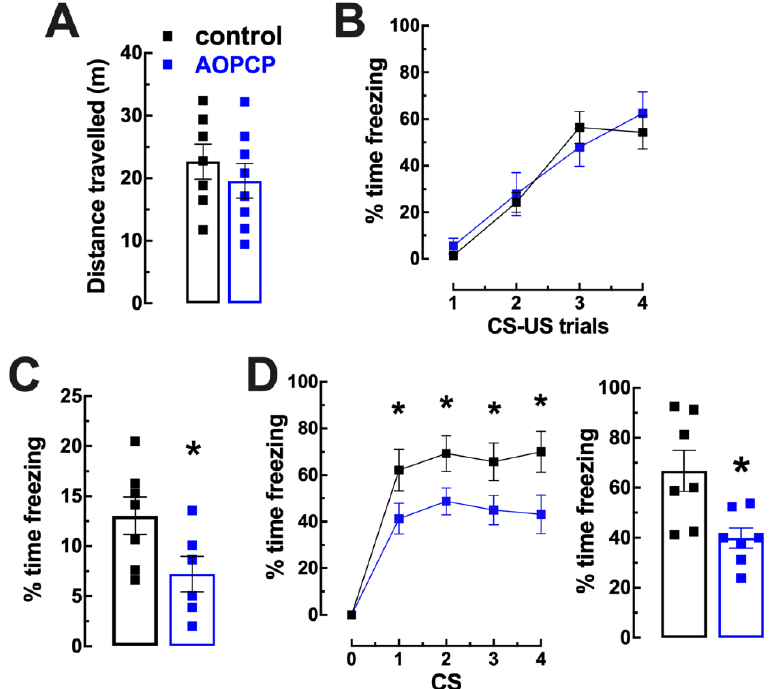
Figure 2. Pharmacological inhibition of CD73 before fear conditioning decreased contextual and cued fear memory in wild type mice. ( A ) Locomotor activity of AOPCP- and saline-treated wild type mice. The icv administration of AOPCP to CD73 wild-type (WT) mice (WT littermates of the CD73 knockout colony) did not change the locomotor profile compared to the control (saline-treated) group. ( B ) Fear conditioning of AOPCP-treated and saline-treated mice: freezing responses to